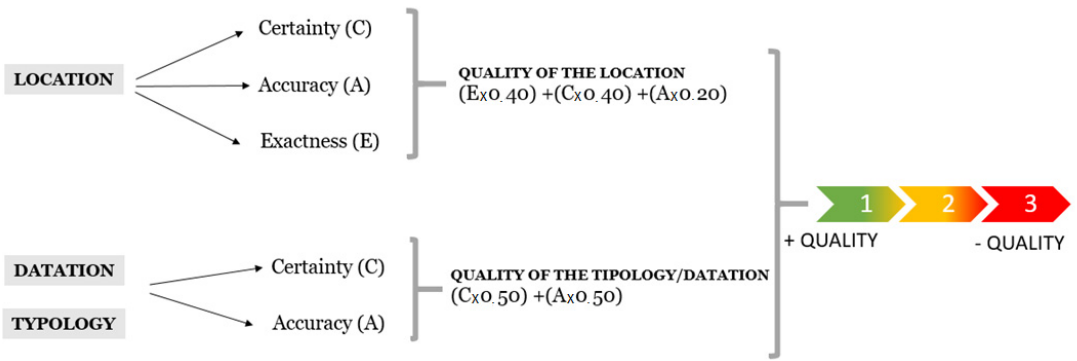
Figure 6. Of the application of data quality measurement criteria.